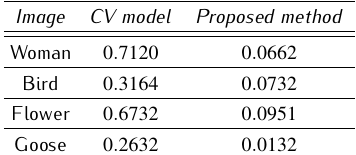
Table 1. SER in Performance